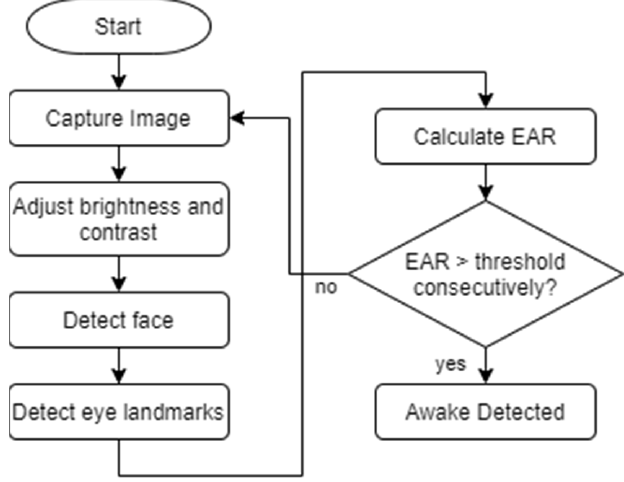
Figure 5. Flowchart for awake detection (EAR = eye aspect ratio).